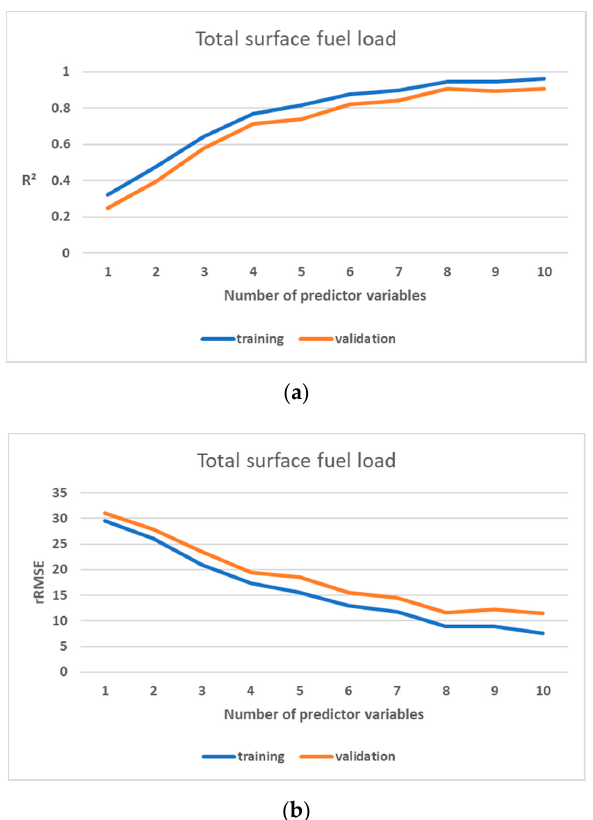
Figure 3. ( a ) Coe ffi cient of determination (R 2 ) of the regression models for total surface fuel load (TSFL) estimation derived from the leave-one-out cross-validation (LOOCV) process versus the di ff erent numbers of predictor variables (i.e., LiDAR-derived structural and intensity metrics) for total surface fuel load (TSFL), ( b ) relative root mean squared error (rRMSE) of the regression models for TSFL estimation derived from the models’ training (blue line) and LOOCV process (orange line) versus the di ff erent numbers of predictor variables. Table 4. The goodness-of-fit statistical measures obtained from the leave-one-out cross validation (LOOCV) process and employed transformations of the response variables in each developed regression model including the LiDAR height distribution metrics for the estimation of the total and surface fuel types’ load (TSFL and load of each surface fuel type (SFTL), respectively). TSFL includes the load of all surface fuel types (SFTs) sampled in each plots (i.e., litter, grass and forbs, shrubs, regeneration, 1-h, 10-h, and 100-h